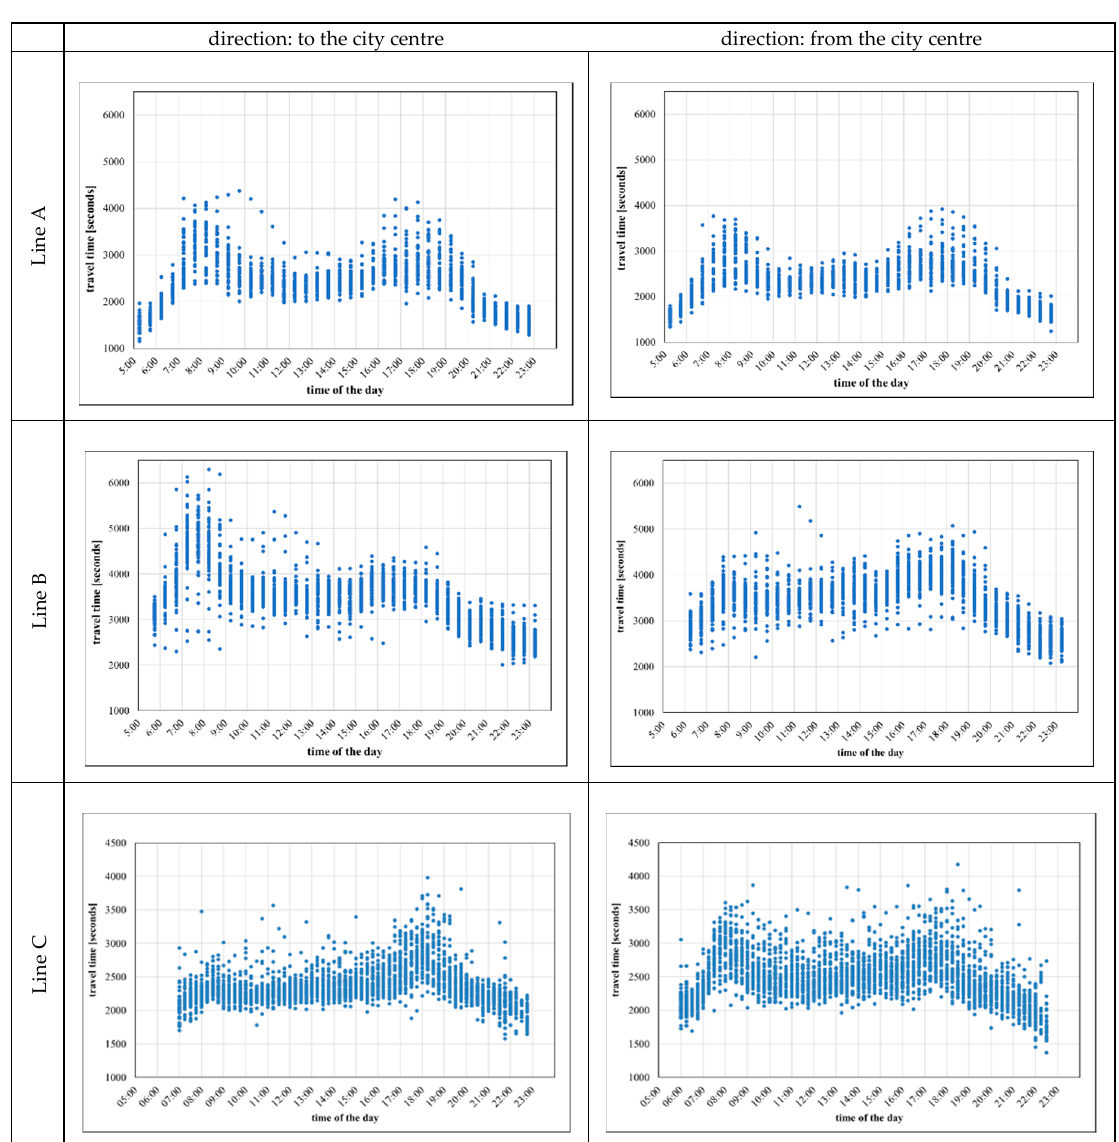
Figure 3. Analysed bus lines: hourly fluctuation of travel time during working days.